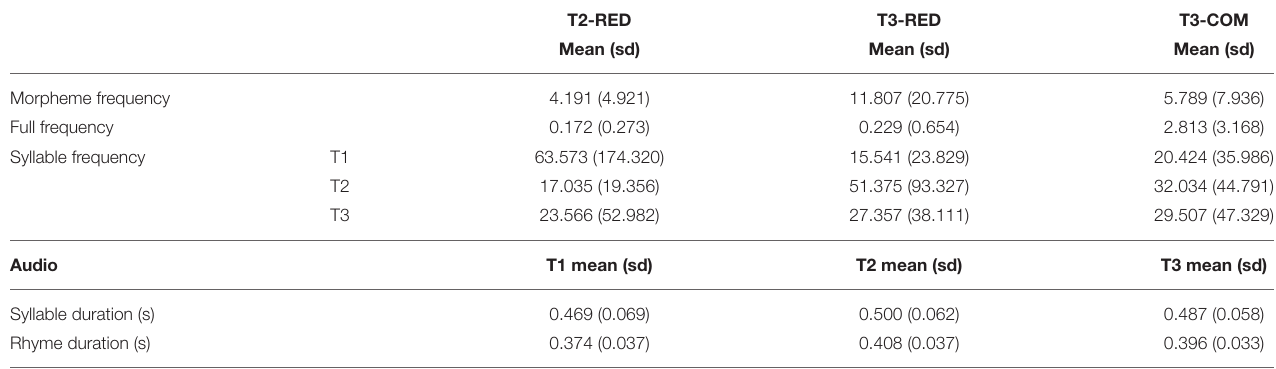
TABLE 2 | Morpheme, full-form and syllable frequencies and